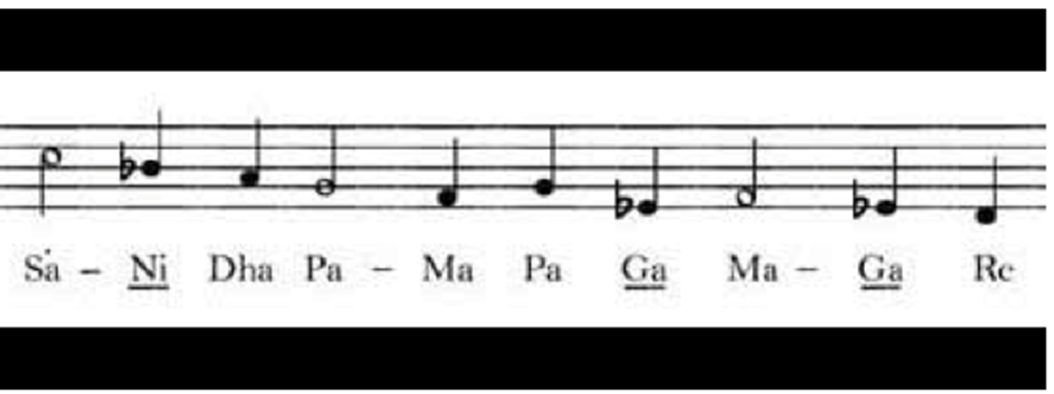
Figure 5. Image of raga Bheempalasi notes.